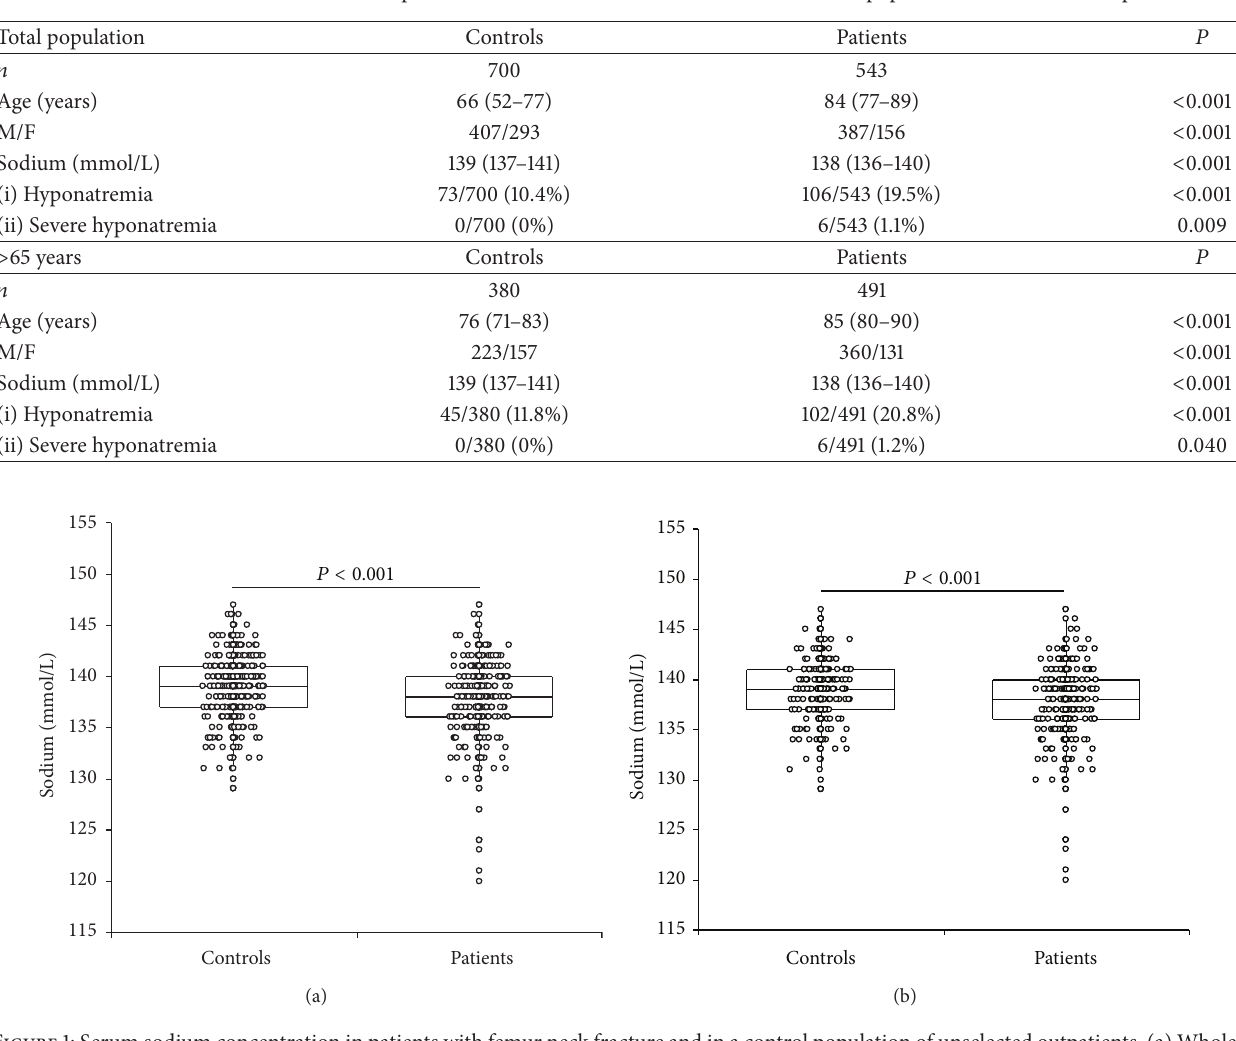
Table 1: Serum sodium concentration in patients with femoral neck fracture and in a control population of unselected outpatients.